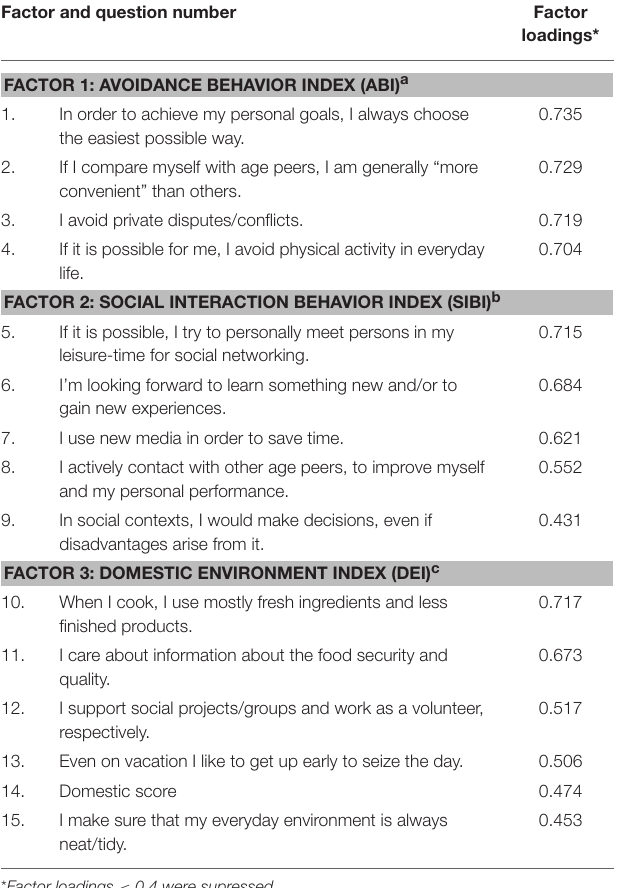
TABLE 2 | Factor-loading matrix and Cronbach’s α of the items about convenience-related behavior ( n = 1233). Factor and question number